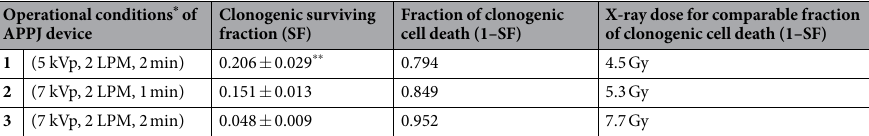
Table 2. Surviving fractions of MECs from plasma treatments under three different operational conditions of the APPJ device and the approximate X-ray doses that would cause the comparable fractions of clonogenic cell death. * (applied voltage, helium gas flow rate, duration of treatment). ** standard